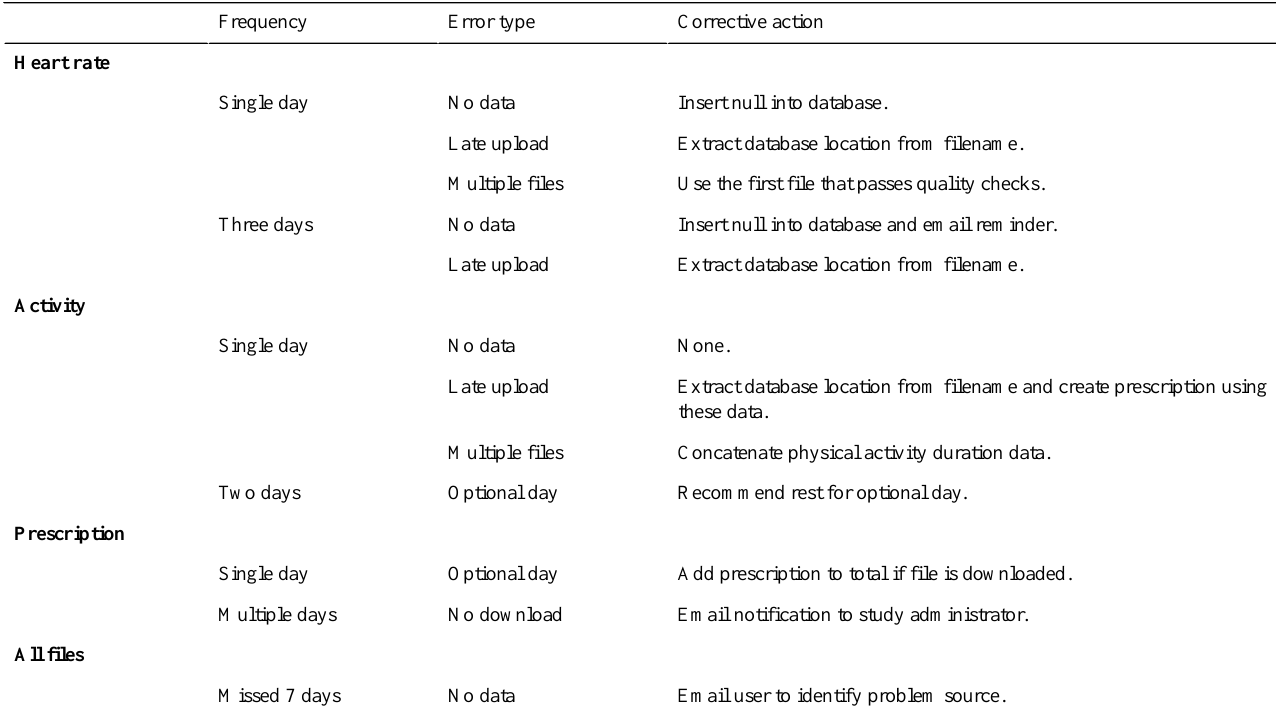
Table 2. Remote administrative data monitoring features in the PPAP